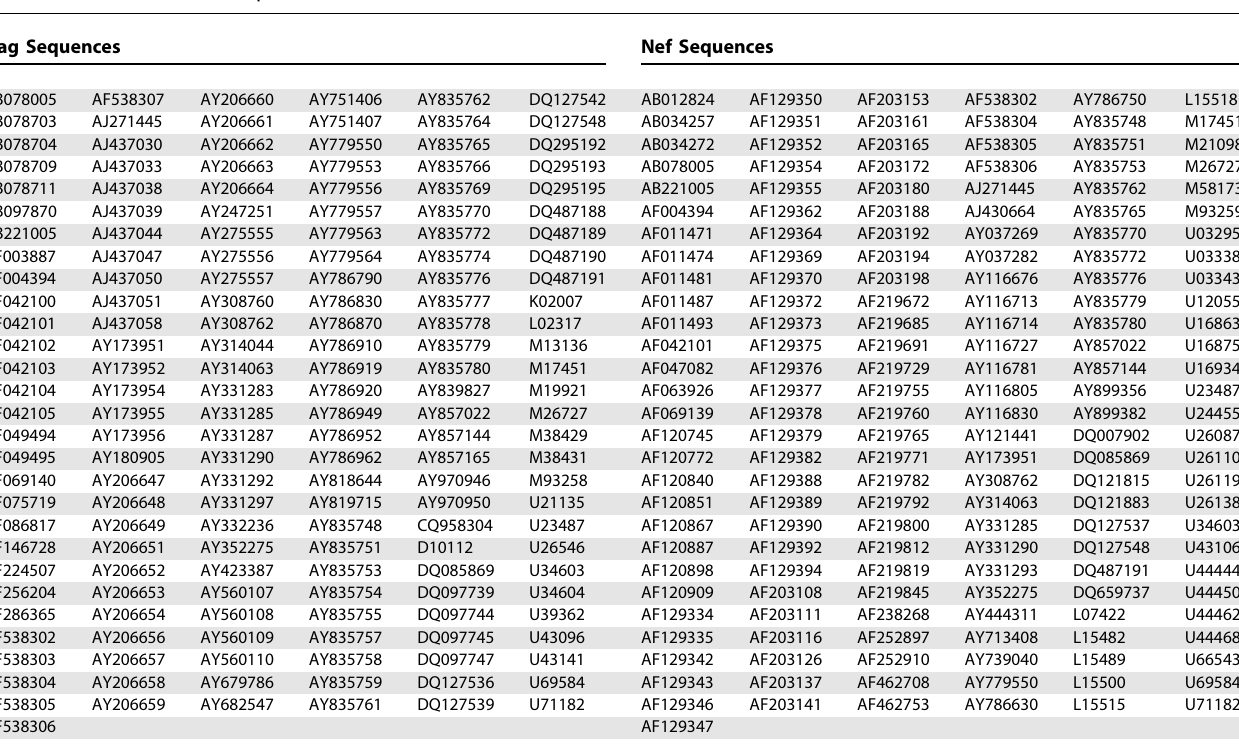
Table 1. GenBank IDs of Sequences